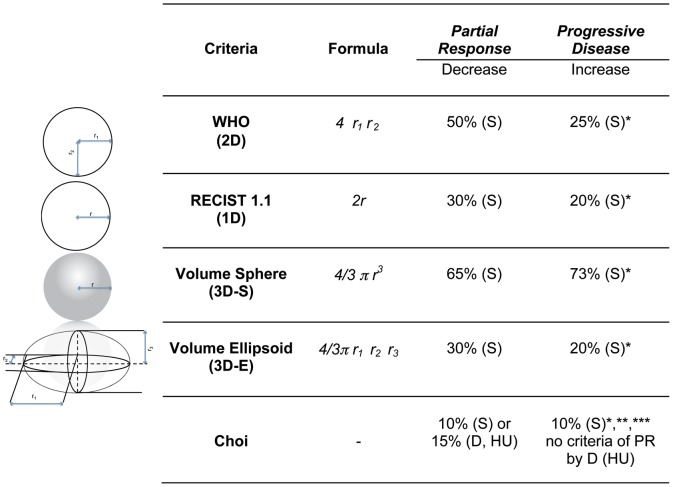
Size-based and Choi criteria.Different size-based criteria and Choi criteria with relative geometrically derived-cut-offs for partial response (PR) and progressive disease (PD). Corresponding geometrical shapes are shown at the left side of the figure. Stable disease (SD) corresponds to intermediate changes between PR and PD. Abbreviations: CT, computed tomography; D, tumor density; HU, Hounsfield unit; r, ri (i = 1,2,3), radius; RECIST, Response Evaluation Criteria in Solid Tumors; S, size. Symbols: *appearance of a new lesion, **new intra-tumoral nodules or increase in the size of the existing intra-tumoral nodules, *** the sum of the longest diameters of target lesions as defined in RECIST [30].